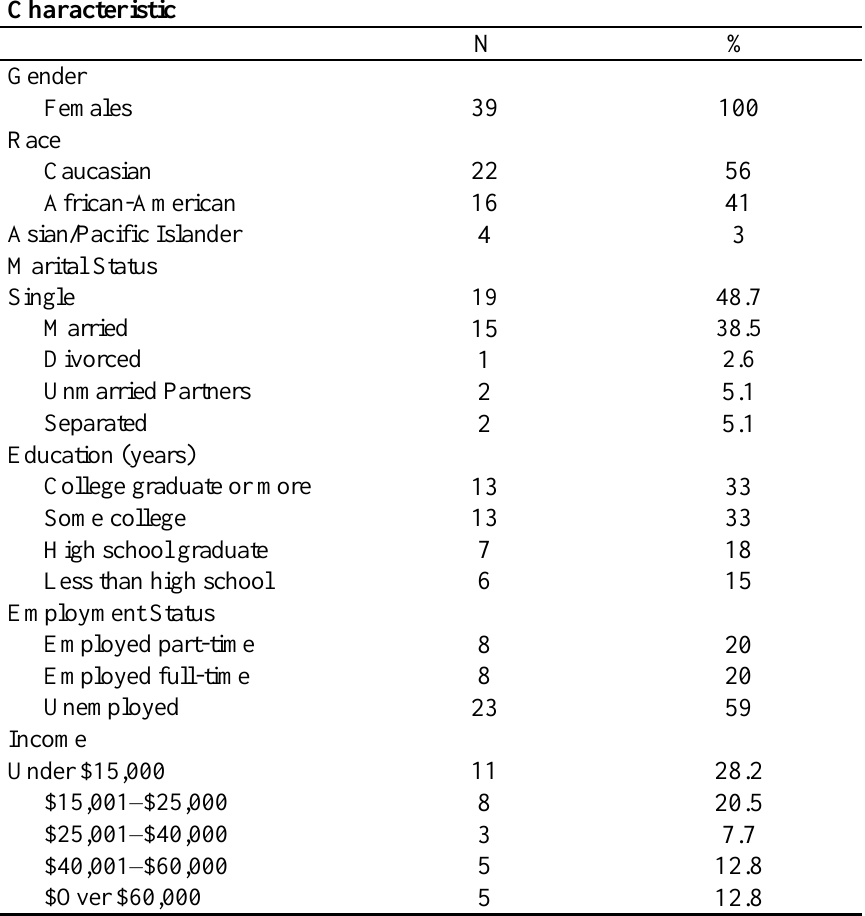
Table 1. Demographic Characteristic (total N =